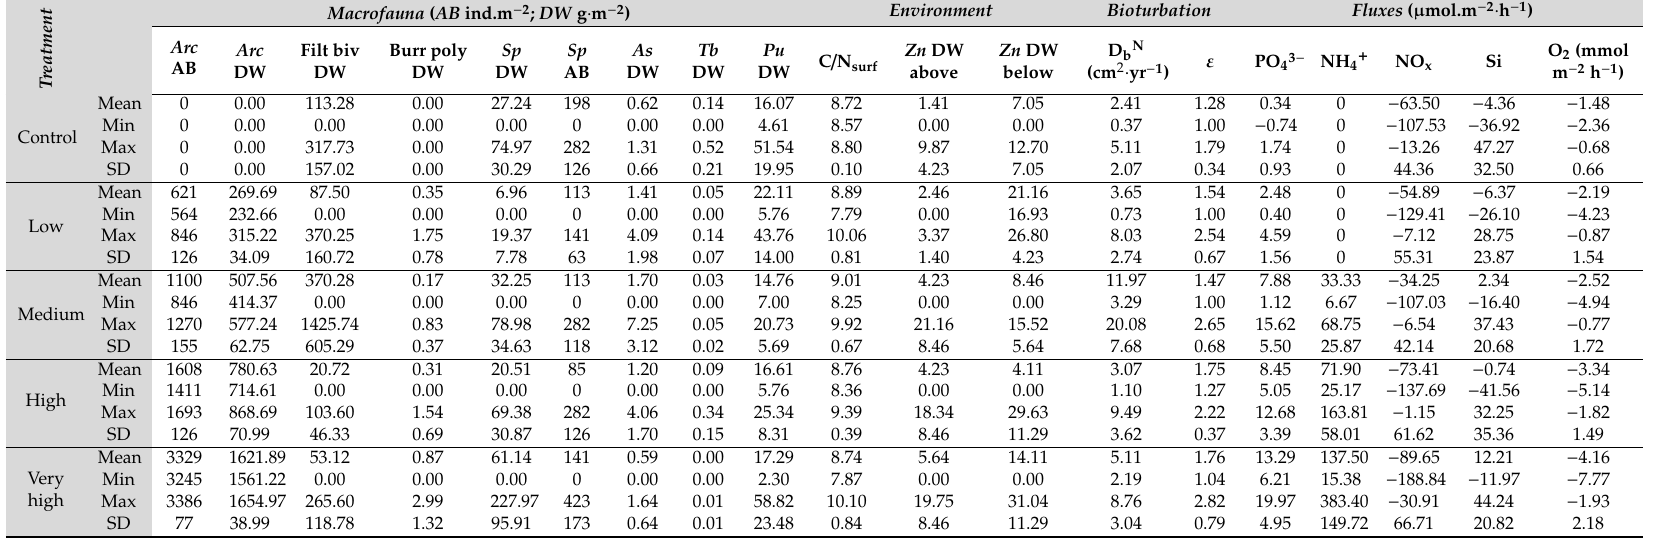
Table 1. Variables measured in experimental cores (treatment-wise mean, maximum, minimum and standard deviation, n = 5): macrofauna abundance (AB) and dry weight (DW) (Arc: A. senhousia , Filt biv: filtering bivalves, Burr poly: burrowing polychaetes, Sp: S. plana , As: A. segmentum , Tb: T. benedii , Pu: P. ulvae ), environmental variables (C / N ratio of surface sediment, dry weight of above- and belowground Z. noltei in g · m − 2 ), bioturbation (Normal biodi ff usion coe ffi cient D bN for particle mixing and biodi ff usion enhancement factor ε for bioirrigation) and fluxes across the